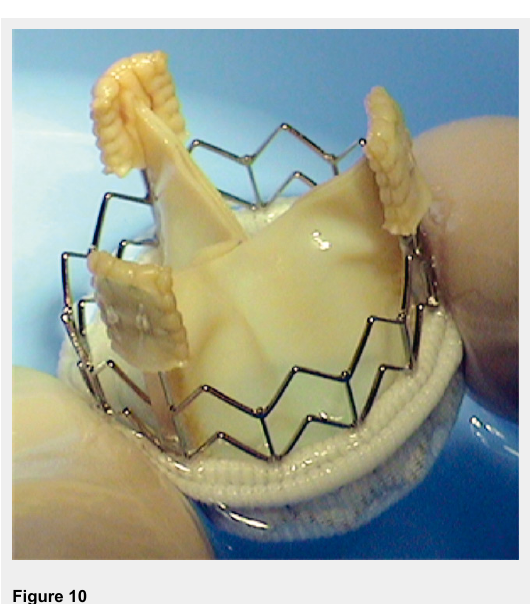
The ATS 3F ® sutureless